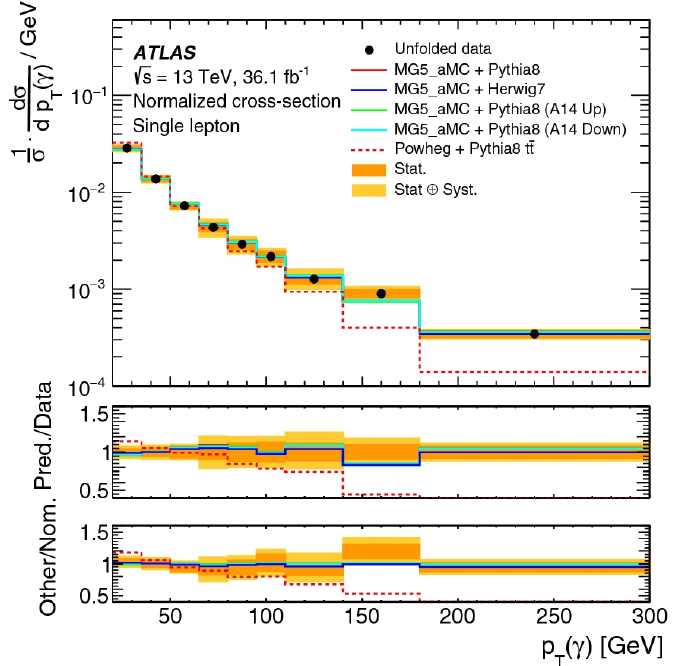
Figure 22. Normalised differential cross-section as a function of the photon transverse momen- tum [46]. Unfolded distributions are compared with predictions using the MG5 a MC + Pythia8 together with up and down variations of the Pythia8A14 tune parameters, the MG5 a MC + Herwig7 and POWHEG + Pythia8 t¯t where the photon radiation is modelled in the parton shower.